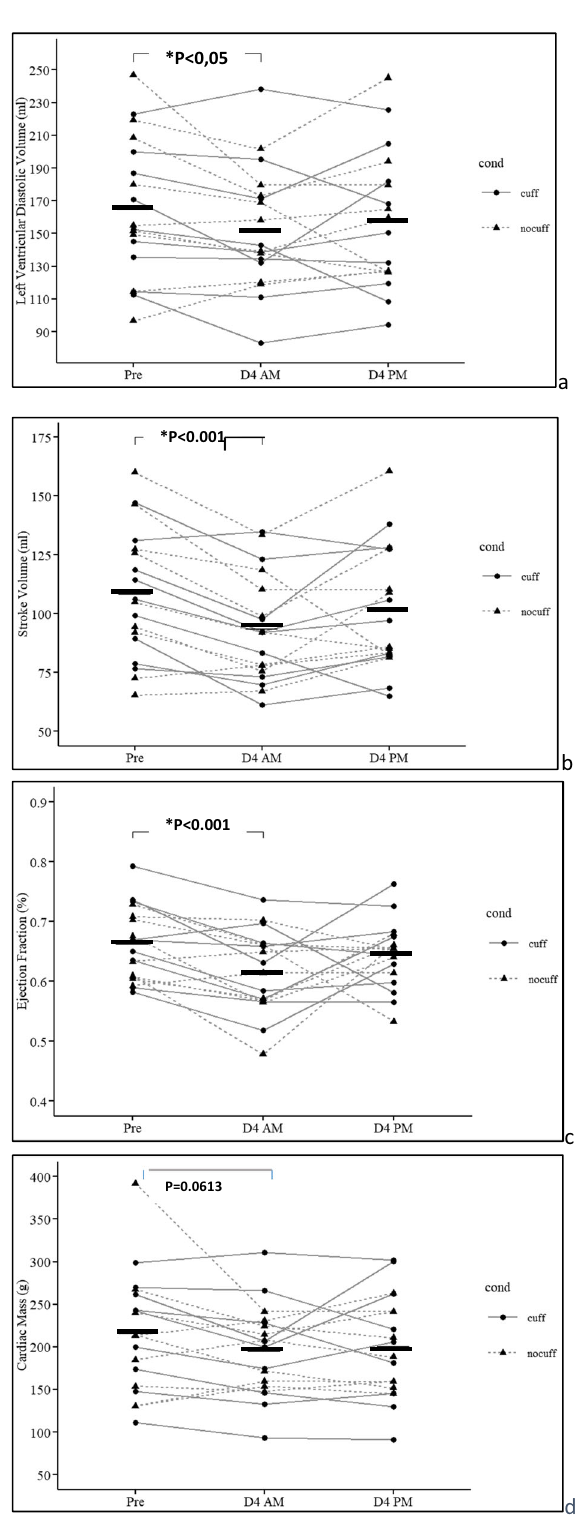
Fig. 1 Cardiac function outcomes from 4 days of dry immersion. Bold horizontal bars represent the mean. DI effect from Pre to D4 AM on the 2 gr averaged (* p ) is reported as “ * p < 0.0 x ” and is plotted on top of the diagram. The change from D4 AM to D4 PM (with or without cuffs) are not signi fi cant for any parameter ( p not reported). Pre was prior to dry immersion; D4 AM represents 4 days of dry immersion (morning prior to donning cuffs for the day for the cuff gr). D4 PM represent the data in the afternoon of day 4, after 10 h with cuff on, for the cuff